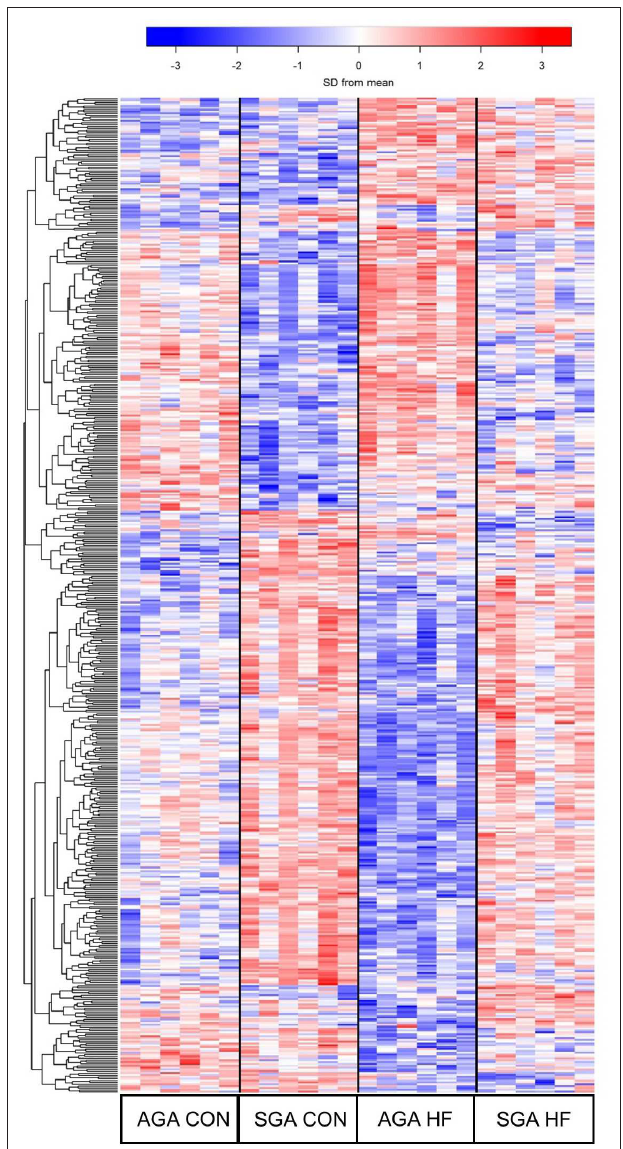
FIGURE 5 | Heat map demonstrating the unique gene expression patterns in the hippocampi due to SGA and HF diet. Each row represents a gene and its relative expression (blue = down-regulation; red = up-regulation) in each piglet. 319 DEGs were identified in response to SGA, 105 DEGs were identified in response to diet, and 24 DEGs were involved in a SGA by diet interaction. AGA CON n = 6, AGA HF n = 6, SGA CON n = 6, SGA HF n = 6. AGA,